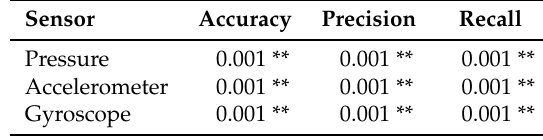
Table 7. The t-test of results performance between the combination of accelerometer-gyroscope sensors against other combinations and individual types of sensors on the SVM algorithm.